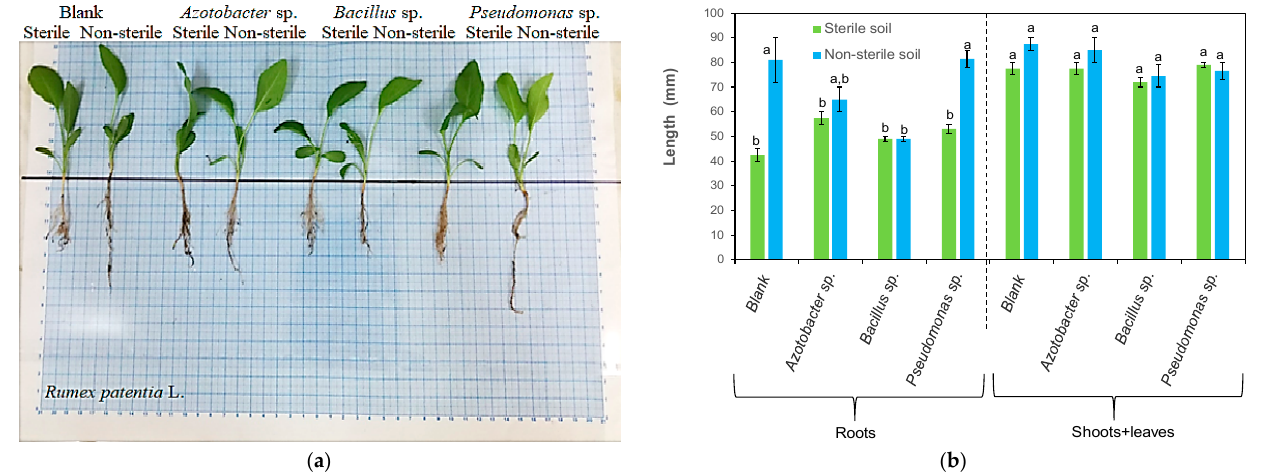
Figure 7. Effects of Azotobacter , Bacillus and Pseudomonas species on Rumex patientia L.: ( a ) visual aspect of plants and ( b ) the root and shoot/leaf length (error bars represent the experimental error; means that do not share a letter are significantly different according to the Tukey’s HSD test).